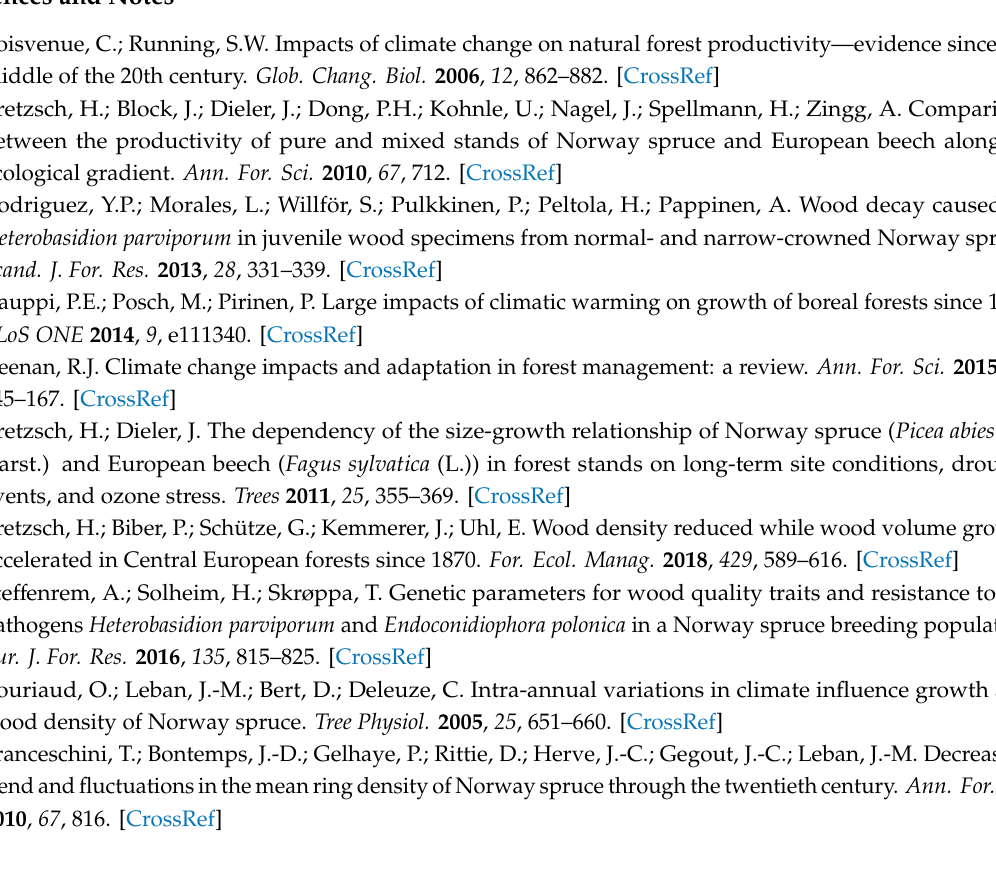
Figure S1: Example of field design: Replication 2 in M ă neciu trial. Table S1: ANOVA for the phenotypic traits in M ă neciu and Soveja